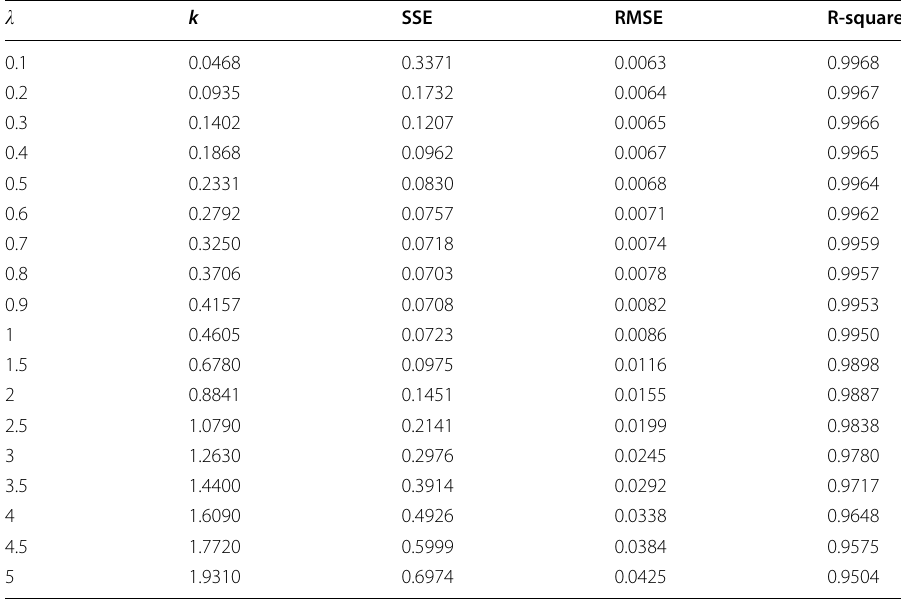
Table 2 The slope k and the degree of linear approximation of the GLHS functions with different scaling parameters